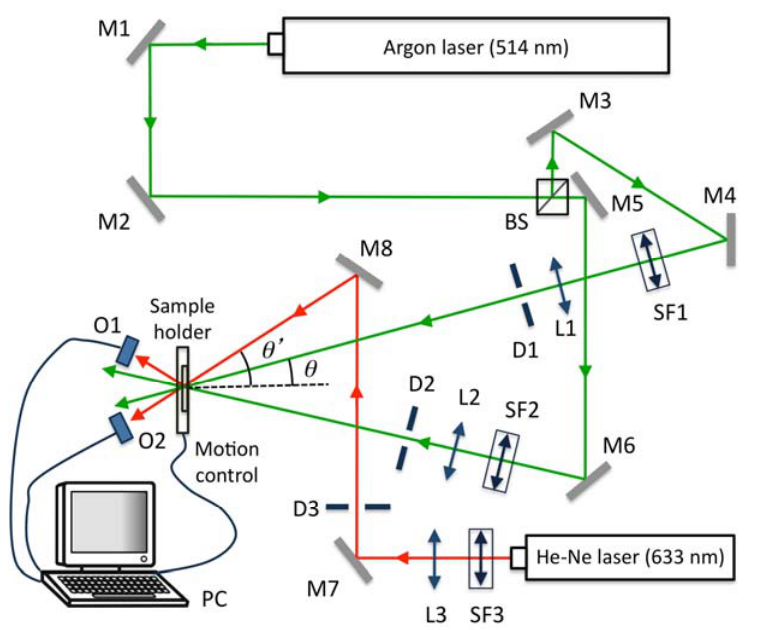
Figure 10. Experimental set-up for analyzing volume holograms in photopolymer.